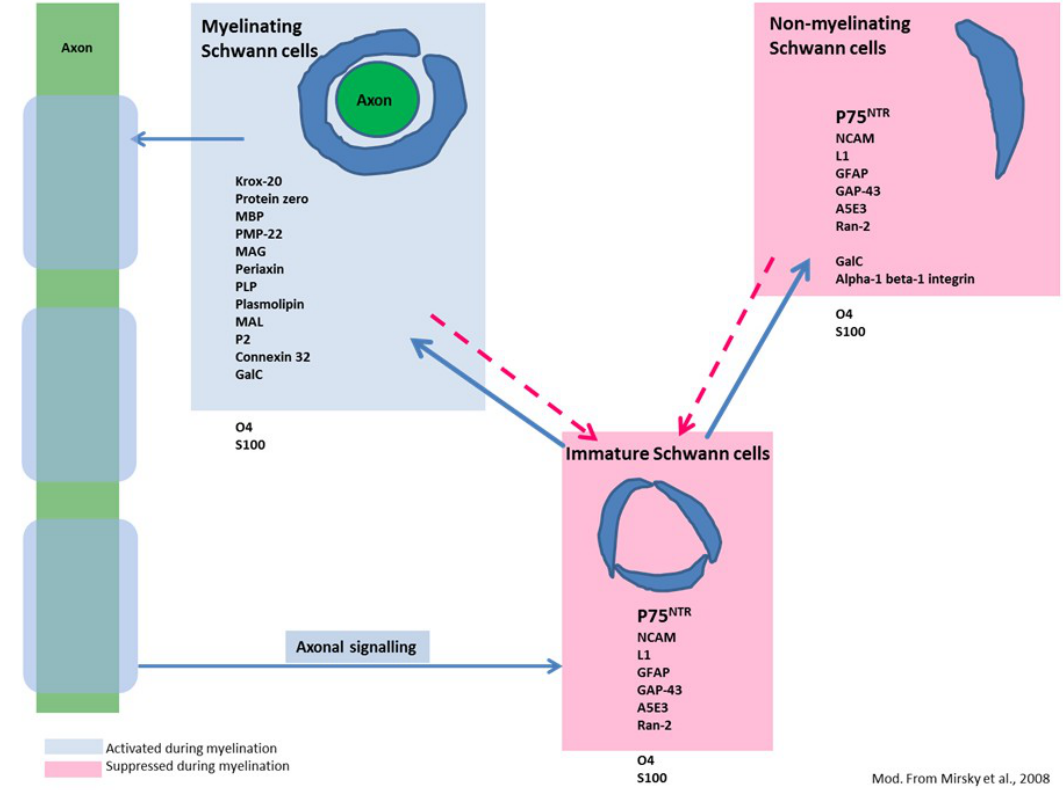
Figure 5. Differentiation stages of Schwann cells and commonly expressed molecules. Unlike oligodendrocytes, immature Schwann cells may differentiate into two distinct phenotypes, myelinating (left) and non-myelinating (right) Schwann cells. However, differentiation is reversible as indicated by the dotted arrows. Blue boxes represent markers of myelinating Schwann cells and molecules promoting their differentiation. All of these markers display strong up-regulation in the stage of myelination. Red boxes include markers of non-myelinating and immature Schwann cells, which are down-regulated during myelination. Note that p75 NTR is expressed in all differentiation stages except in myelinating Schwann cells. Whether the detected p75 NTR expressing bipolar cells in CDV-DL differentiate into myelinating Schwann cells is currently not known. Markers and scheme modified from Mirsky et al ., 2008